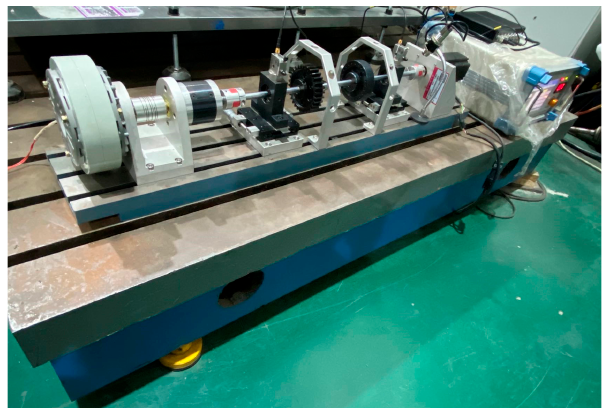
Figure 11. HZXT-008 bearing experimental platform.